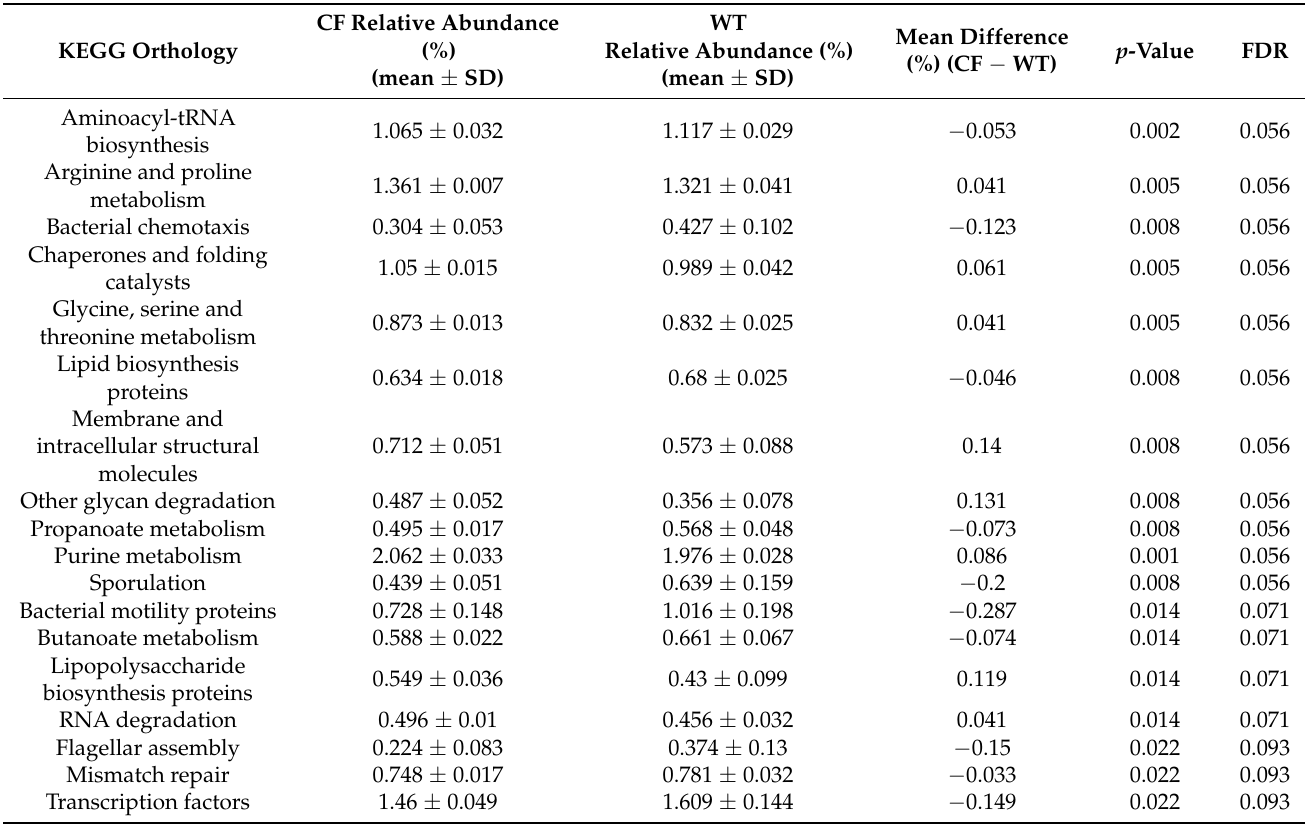
Table 3. Predicted KEGG orthology terms with a significantly different abundance between CF and WT